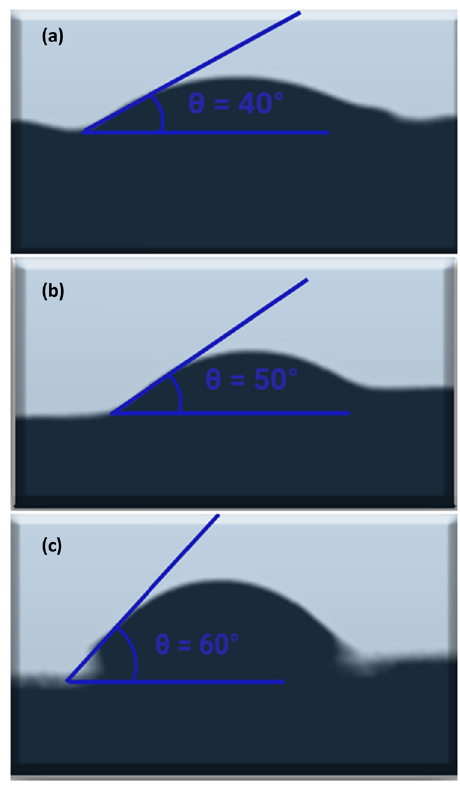
Figure 6: Contact angle micrographs of electrospun nano fi bers: ( a ) PVA/MMT, ( b ) with 0.2 g of the extract, and ( c ) with 0.8 g of the extract.